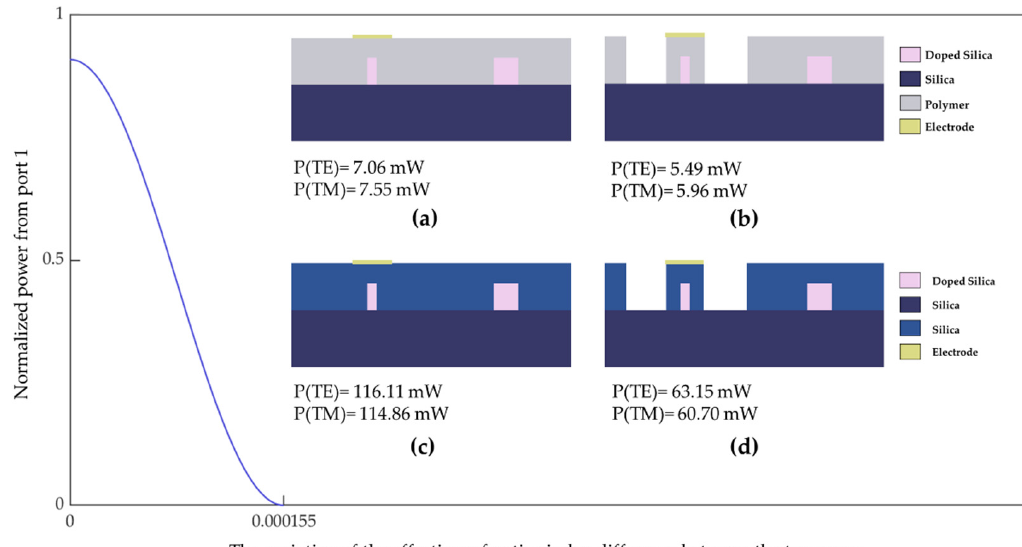
Figure 9. The power consumption to realize the switching function for: ( a ) a polymer/silica device without an air trench, ( b ) a polymer/silica device with an air trench, ( c ) an all-silica device without an air trench, and ( d ) an all-silica device with an air trench.